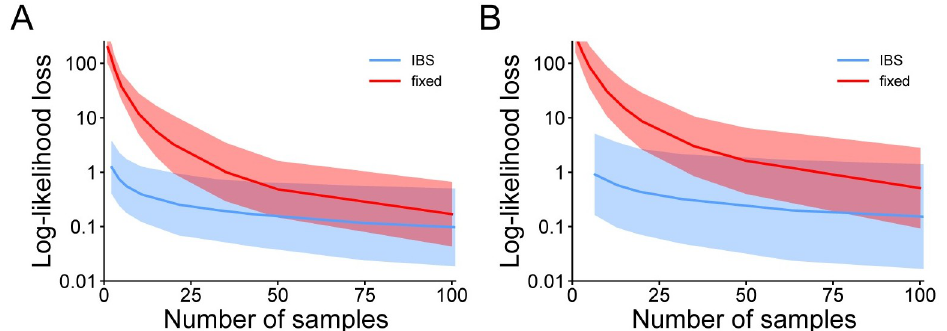
Fig 10. Log-likelihood loss. A . Log-likelihood loss with respect to ground truth, as a function of number of samples, for the orientation discrimination task. Lines are mean ± 1 standard deviation (in log space) across 120 generating parameter values, with 100 simulated datasets each. B . Log-likelihood loss for the change localization task (80 generating parameter values).